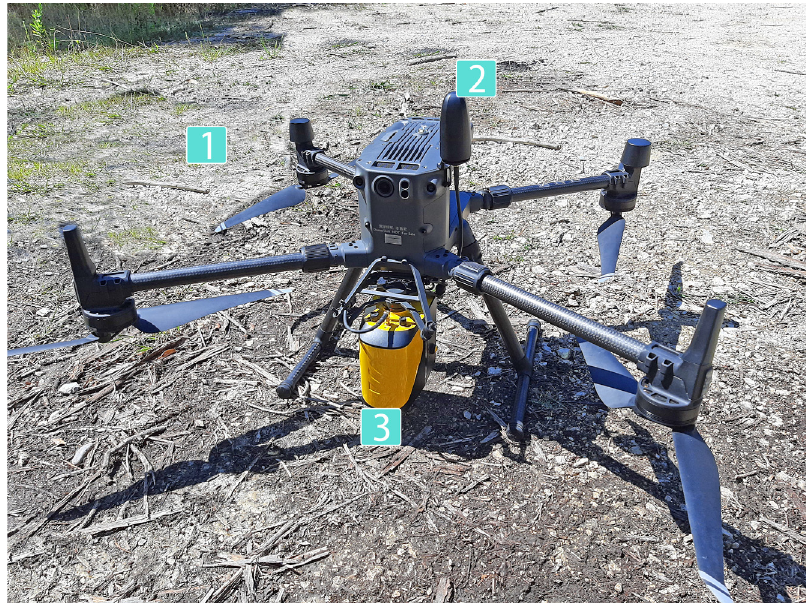
Figure 3. Unmanned aerial vehicle (UAV) used to collect LiDAR point clouds: (1) Matrice 300 RTK; (2) YellowScan RTK Antenna; (3) YellowScan Mapper. (2) YellowScan RTK Antenna; (3) YellowScan